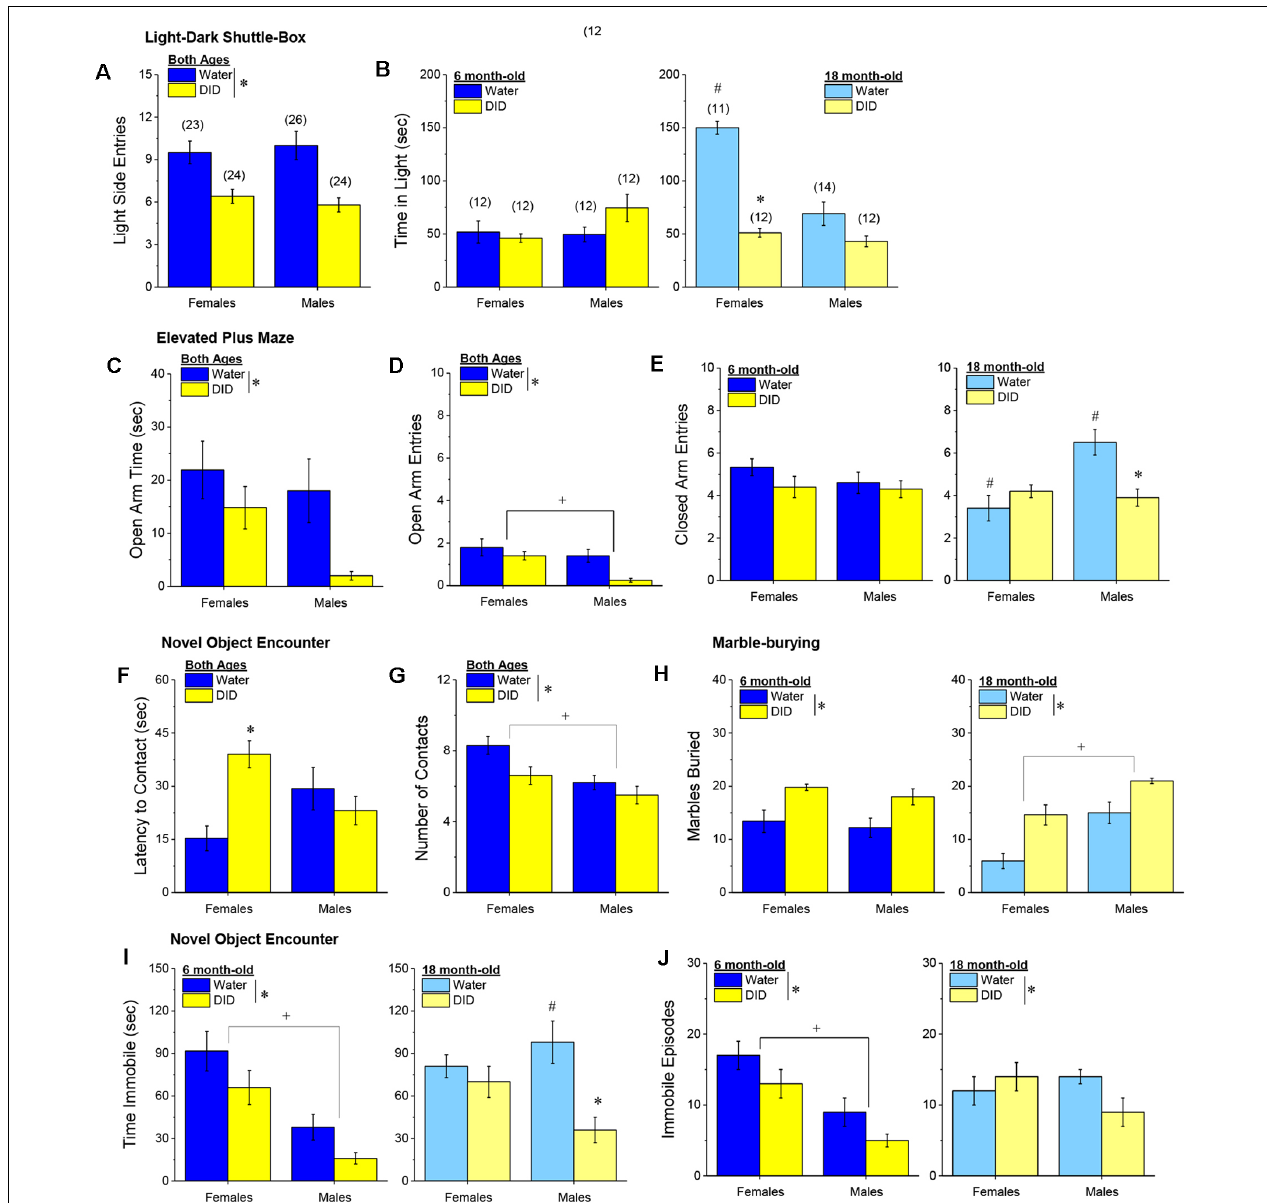
FIGURE 10 | Effects of binge drinking during later maturity (6 months of age) or old age (18 months of age) on behavioral indices of negative affect in isogenic C57BL/6J mice. (A) Regardless of age or sex, binge drinking (DID) lowered the time spent in the light-side of a light-dark shuttle-box, relative to water-drinking controls (Water). (B) Only 18-month-old DID females spent less time than their Water controls in the light-side of the light-dark box. In the elevated plus-maze, DID mice spent less time in (C) and made fewer entries into (D) , the open arm, with males making fewer open arm entries than females, irrespective of drinking history or age. (E) Binge drinking reduced the number of closed arm entries only in male 18-month-old mice. In the novel object encounter test, female DID mice exhibited a longer latency to approach the novel object (F) , and although males approached the novel object less often that females, both male and female DID mice made fewer contacts with the novel object than Water controls (G) . (H) Irrespective of age, DID mice buried more marbles than Water controls, with 18-month-old males burying more marbles than their female counterparts. (I) Both 6-month-old DID mice (left) and male 18-month-old mice (right) spent less time immobile in the forced swim test. (J) A similar pattern of effect was observed with respect to the number of immobile episodes, although the main effect of binge drinking was detected for this variable. The data represent the means ± SEMs of the number of mice indicated in parentheses in Panel (B) . ∗ p < 0.05, DID vs. Water; + p < 0.05, Females vs. Males; # p < 0.05, 6 vs. 18-month-olds.